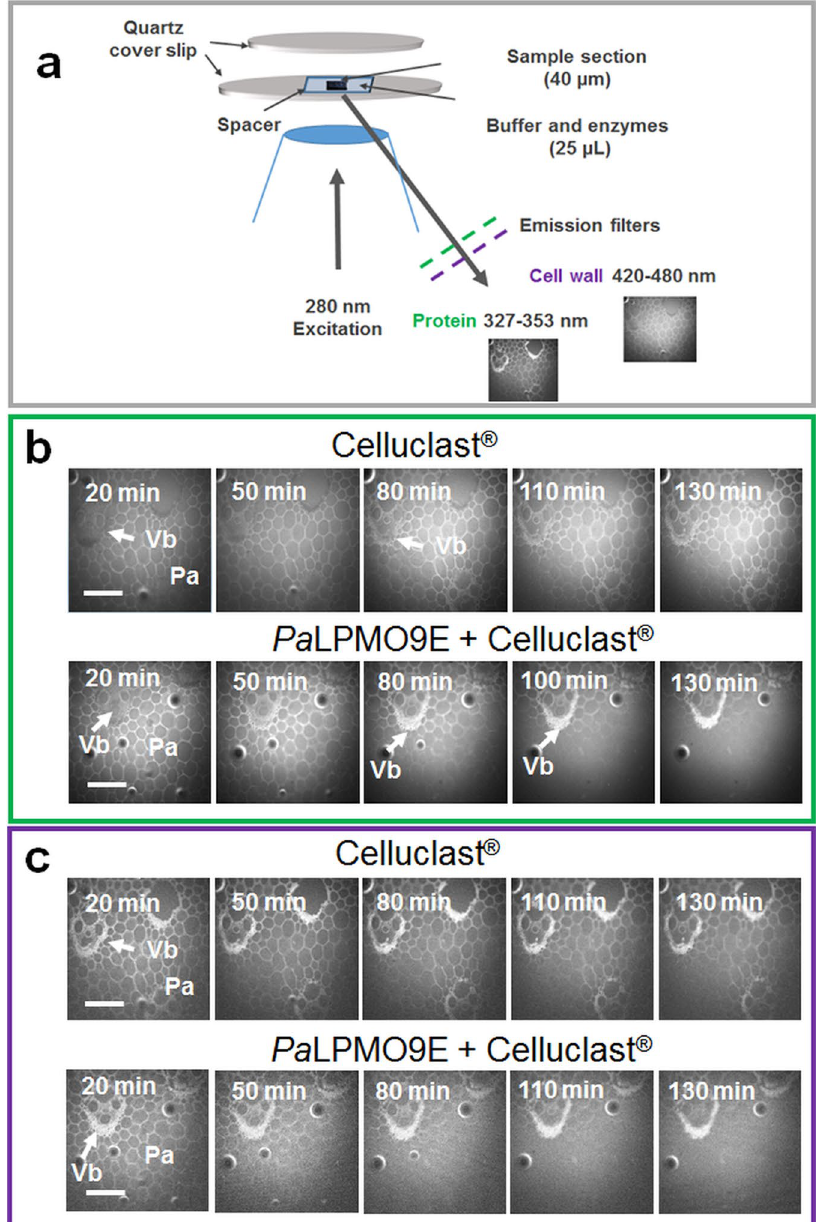
Figure 3. Fluorescence time-lapse imaging of enzymatic conversion of chlorite-treated miscanthus. ( a ) Experimental set-up of the deep-UV fluorescence imaging at synchrotron beamline. ( b ) Evolution of protein fluorescence during hydrolysis by Celluclast ® alone or with Pa LPMO9E. ( c ) Evolution of cell wall fluorescence during hydrolysis by Celluclast ® alone or with Pa LPMO9E. Scale bar is 200 µ